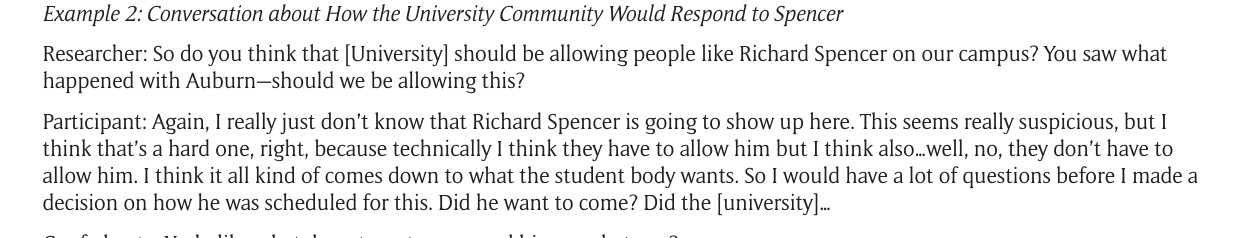
Table 1: Example Exchanges between Participant, Confederate and